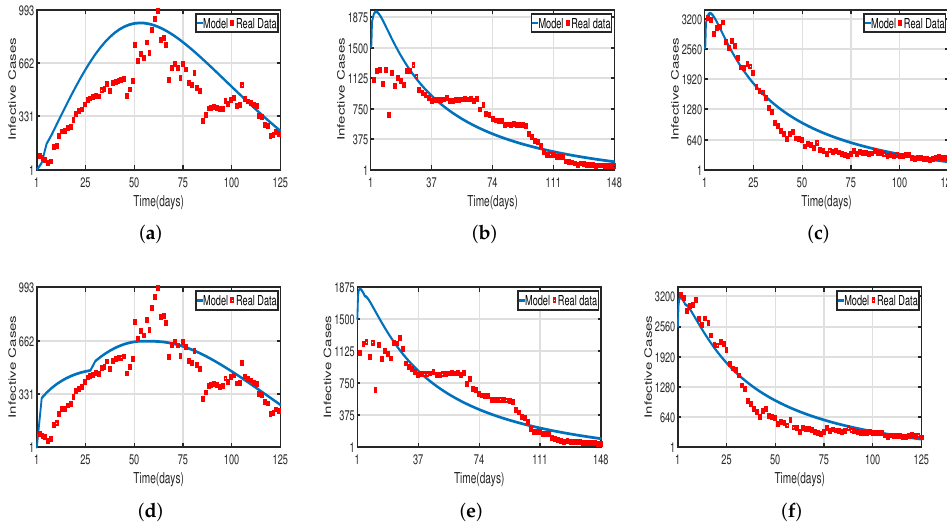
Figure 4. Fitting infected cases of model (2) for COVID-19 versus real observations of infected cases in the UAE. ( a ) Model fitting without the vaccinated population. ( b ) Model fitting with the vaccinated (after 50%) population. ( c ) Model fitting with the vaccinated (after 100%) population. ( d ) Time-delayed model fitting without the vaccinated population. ( e ) Time-delayed model fitting with the vaccinated (after 50%) population. ( f ) Time-delayed model fitting with the vaccinated (after 100%)